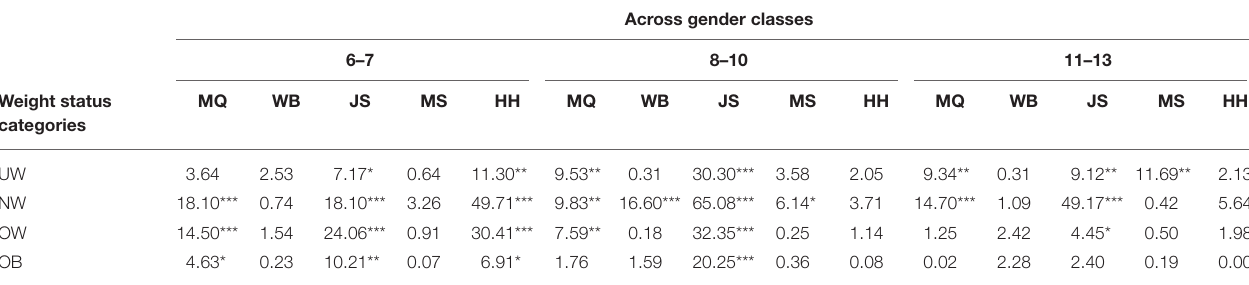
TABLE 5 | F -values and significance levels of differences in the total MQ and subtest scores of the KTK across gender classes by age groups, and weight status categories.